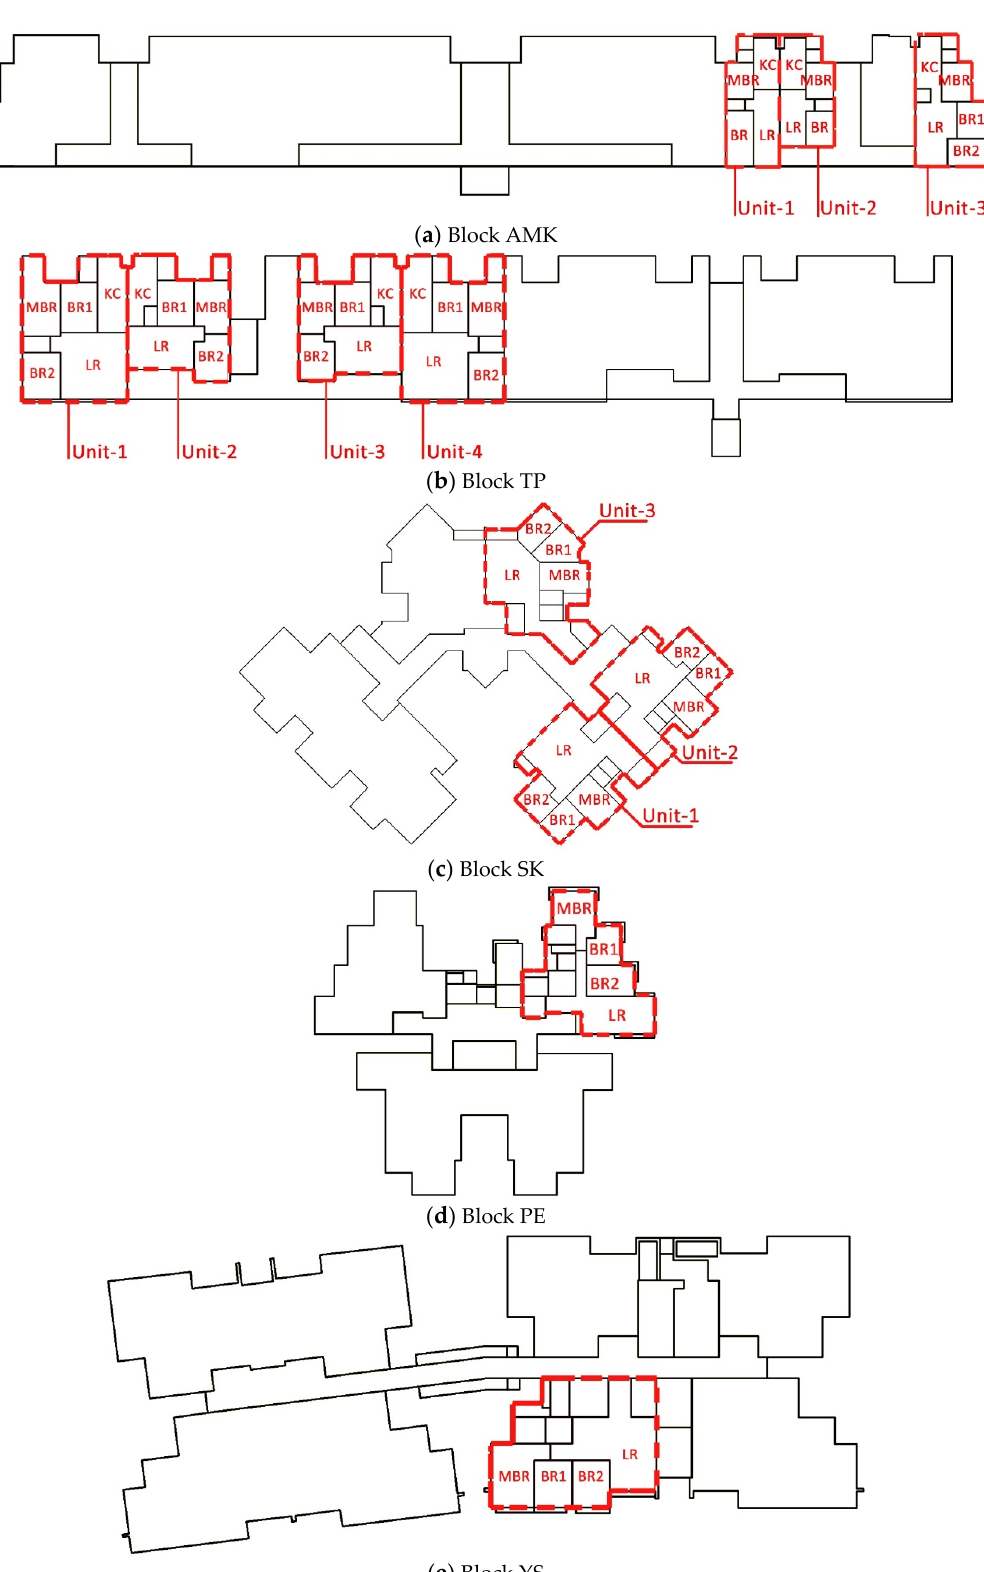
Figure 3. Locations of the target units on the standard floors of the target buildings: ( a ) block